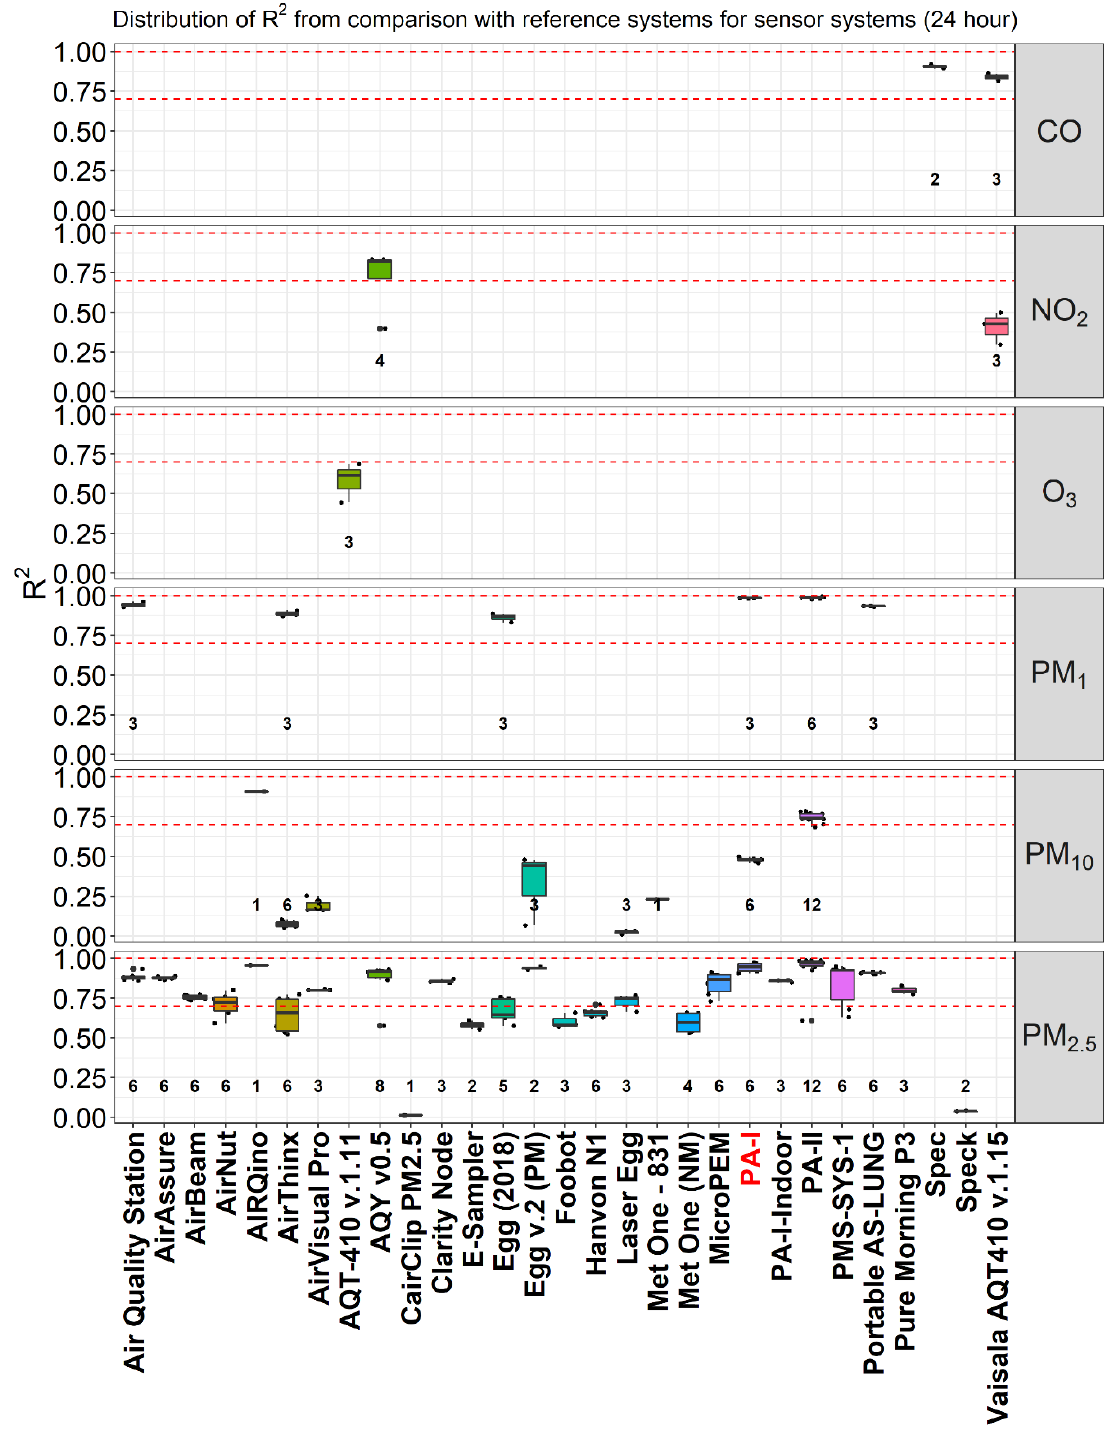
Figure A7. Distribution of R 2 from the comparison of all sensor systems against reference systems. Records were averaged over a time-scale of daily data. Numbers in blue and black indicate the number of open source and black box records, respectively. Names of “living” and “non-living” sensors are indicated by black and red labels on the x-axis, respectively.